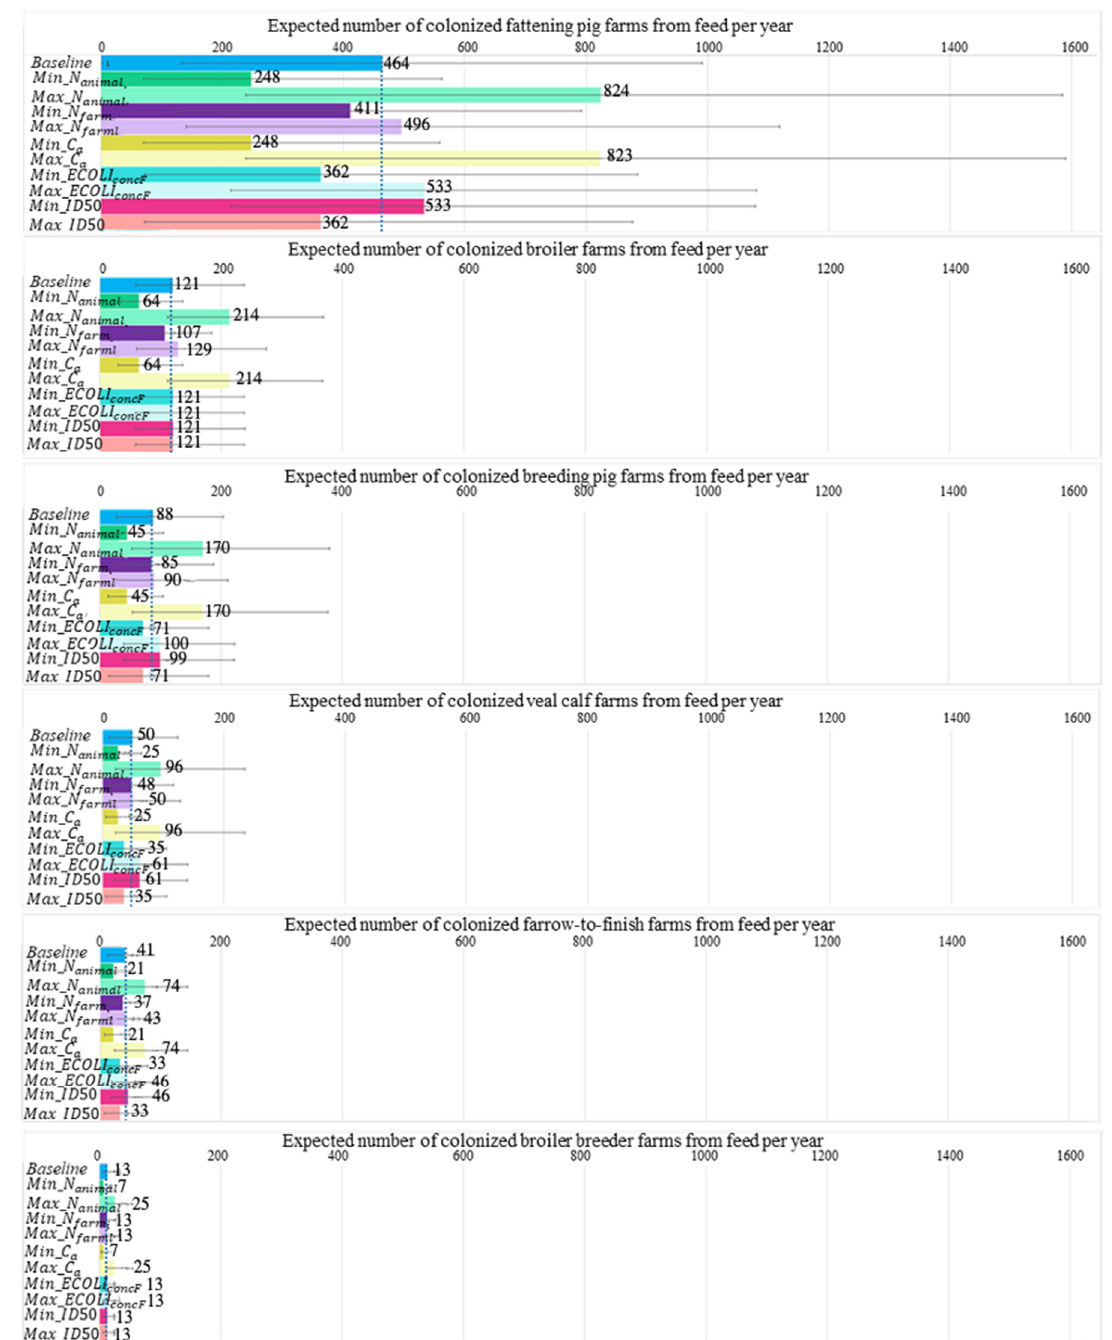
Figure 3. One-at-a-time sensitivity analysis of the number of introductions from feed to six farm types calculated in which one parameter either increases or decreases two-fold. Farm types are ordered according to the highest to lowest number of introductions in the baseline model. Dotted blue line indicates the estimated number of introductions in the baseline model. Only parameters that differed between farm types are included in this figure.